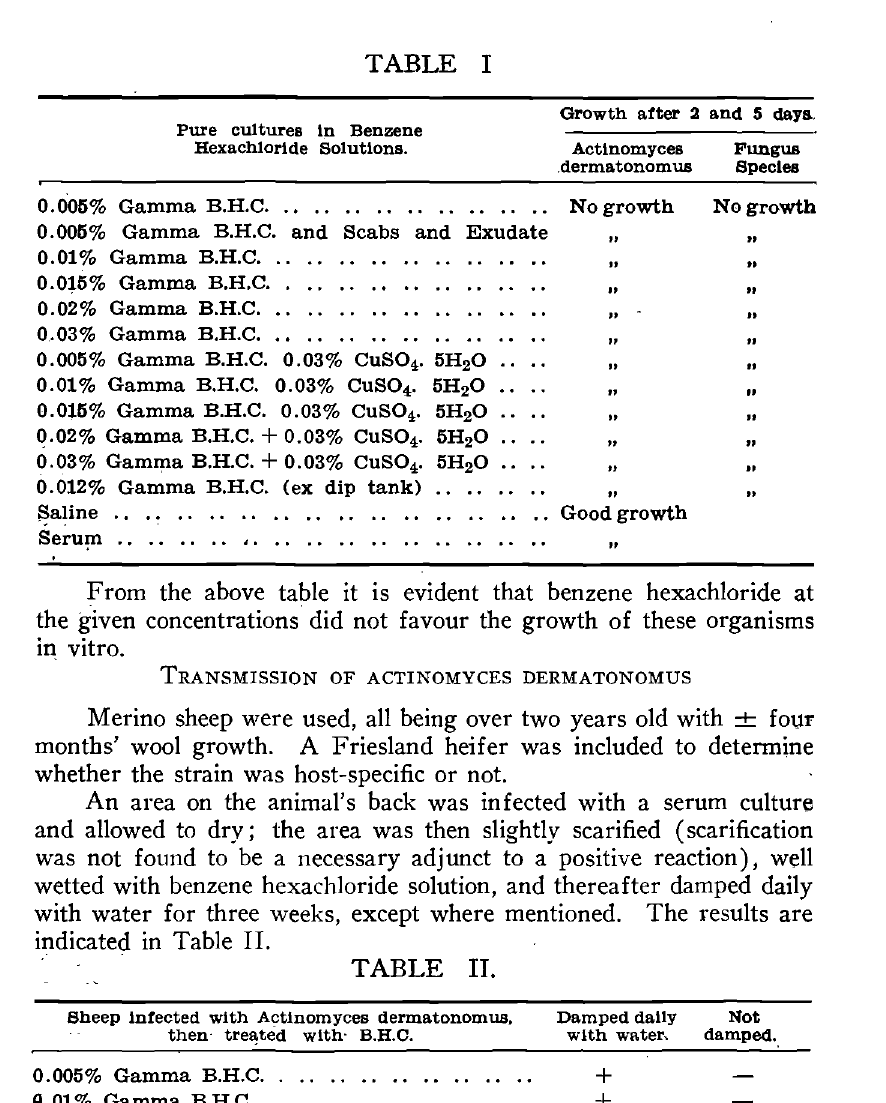
Pure cultures In Benzene Hexachloride